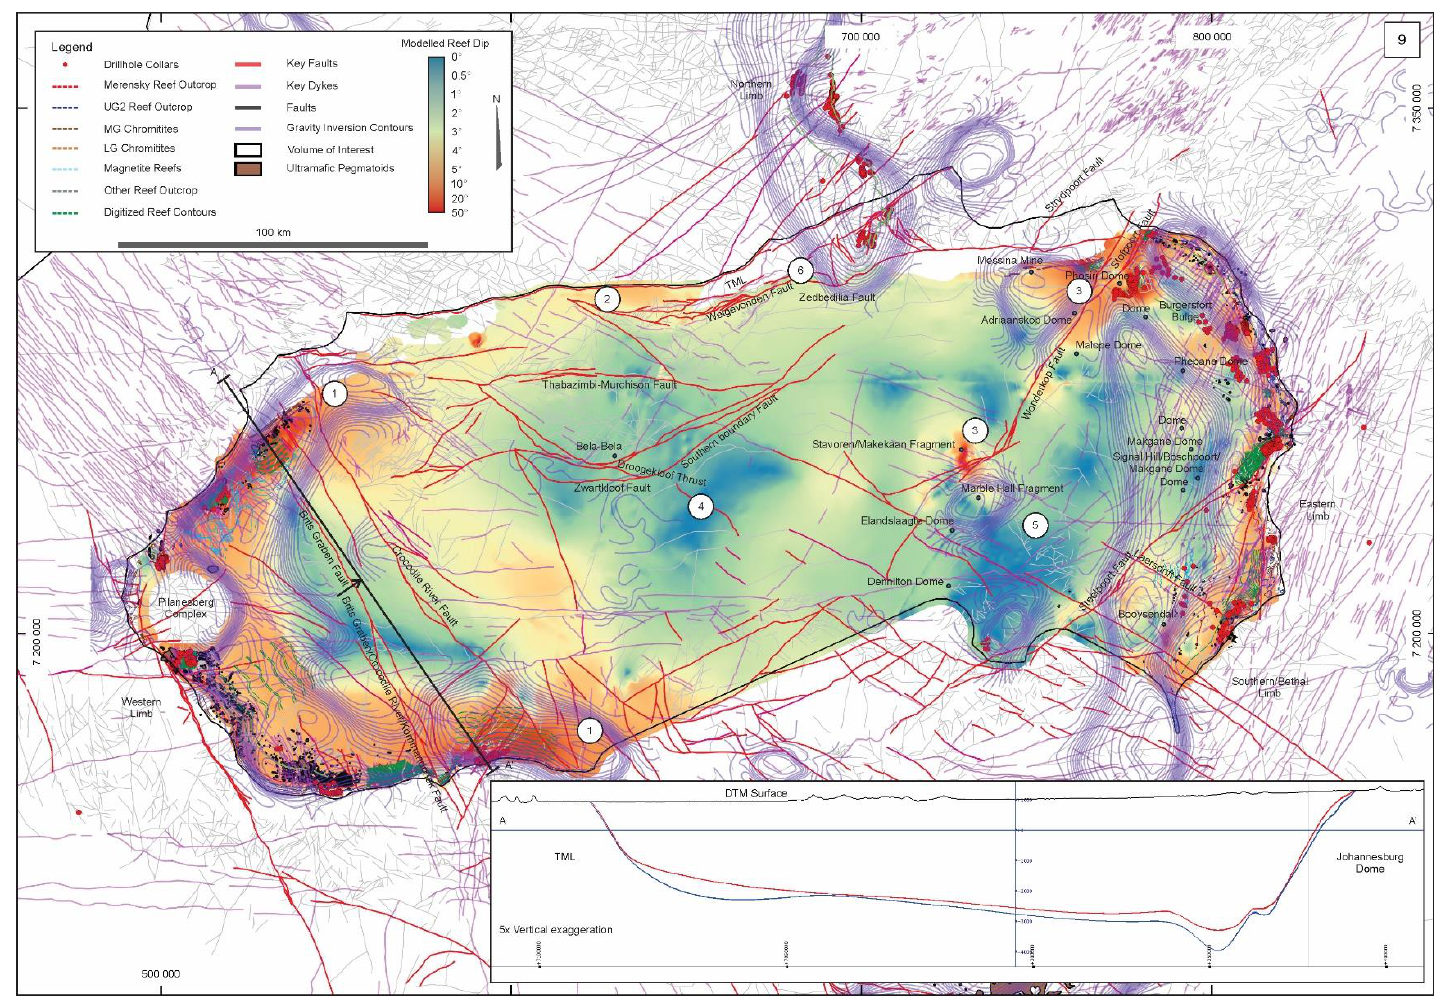
Figure 9. Modelled UG2 Reef surface dips. Position of section line A–A’ indicated on map. Numbered points of interest are discussed in the text.